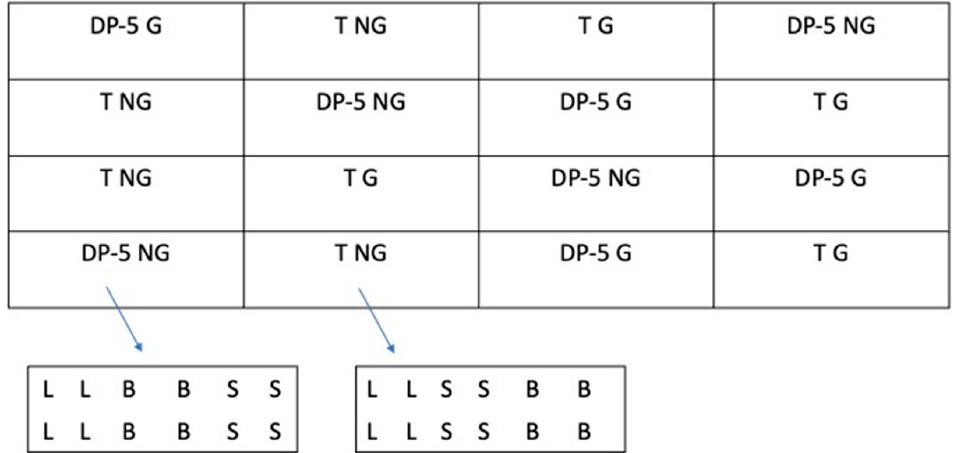
Figure 1. Experimental design of field trial 2014–2015. The whole plot treatments consisting of a planting treatment and glyphosate treatment were arranged in a 2 × 2 factorial and vegetable subplots were randomized within each whole plot. Abbreviations: DP-5 = Directly planted into a hole 5 cm wide × 10 cm deep; T = planted into a tilled strip 2 m long × 15 cm wide; NG = no glyphosate treatment; G = treated with glyphosate; L = lettuce; B = broccoli; S = swiss chard. Two glyphosate treatments were applied one week prior to planting vegetables in mid-September 2014. Half of the whole plots were treated with glyphosate (G) at a rate of 8.9 g ae/l (2% mixed solution, Roundup Pro Concentrate TM , Monsanto, St. Louis, MO, USA) using a sponge mop that applied glyphosate in 20 cm × 15 cm rectangles centered on the location of future transplants. The other half of the plots received no glyphosate